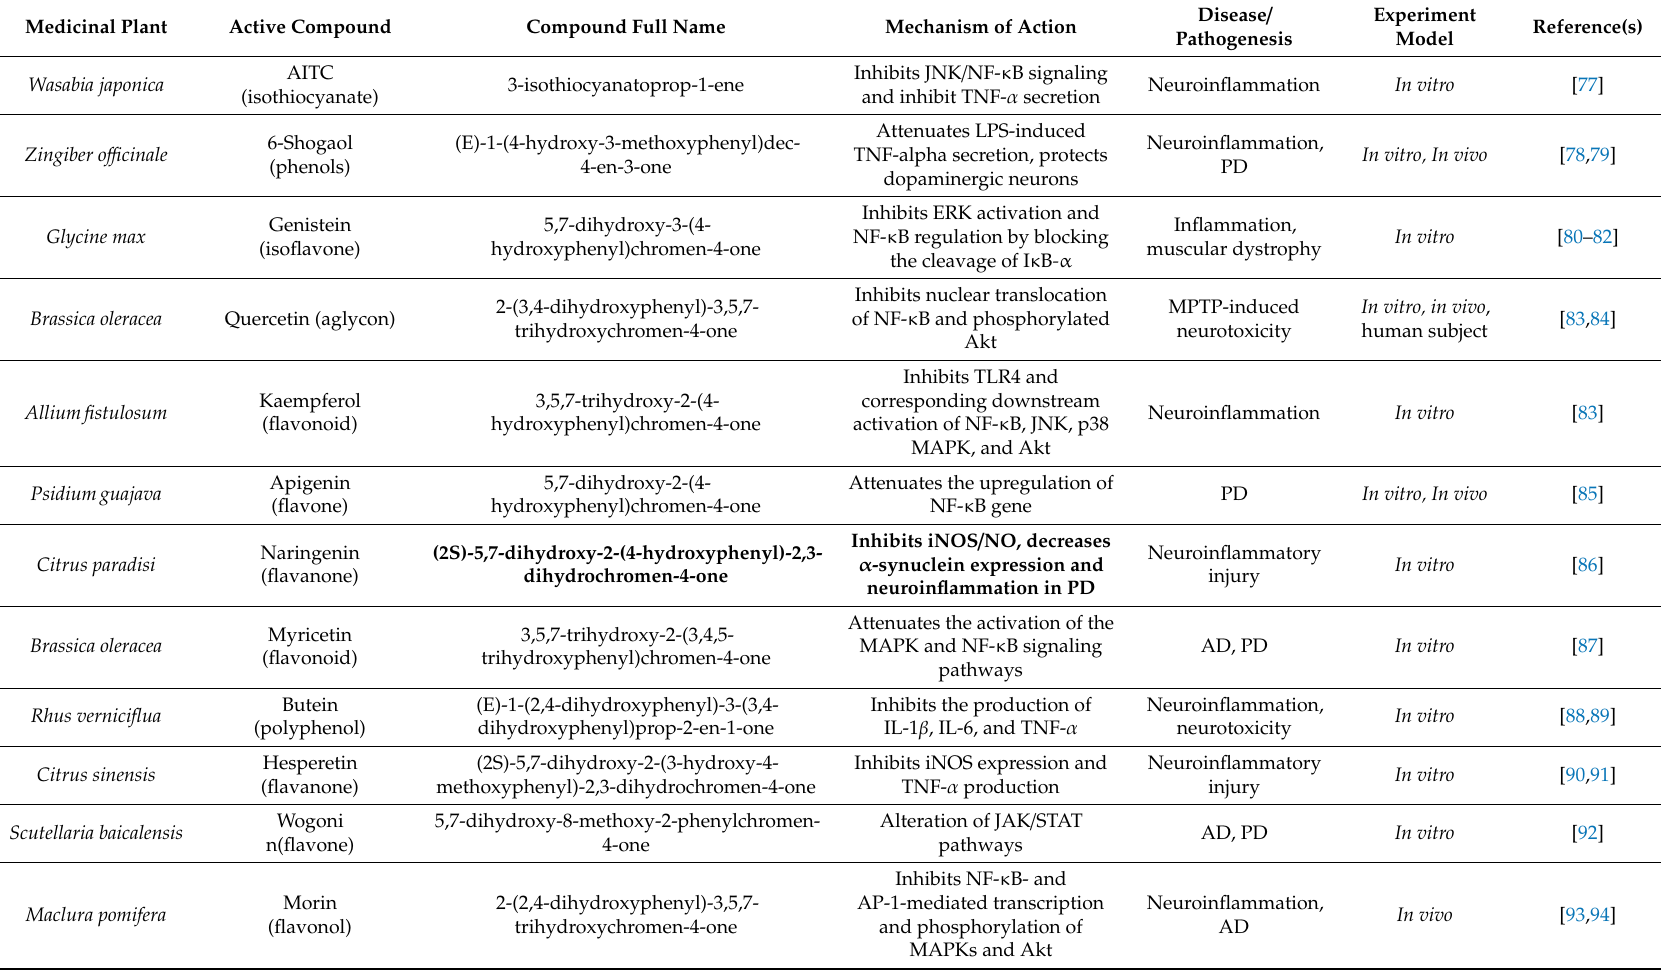
Table 2. TNF- α secretion-inhibiting phytochemicals that play beneficial roles in controlling the pathogenesis of several neuronal